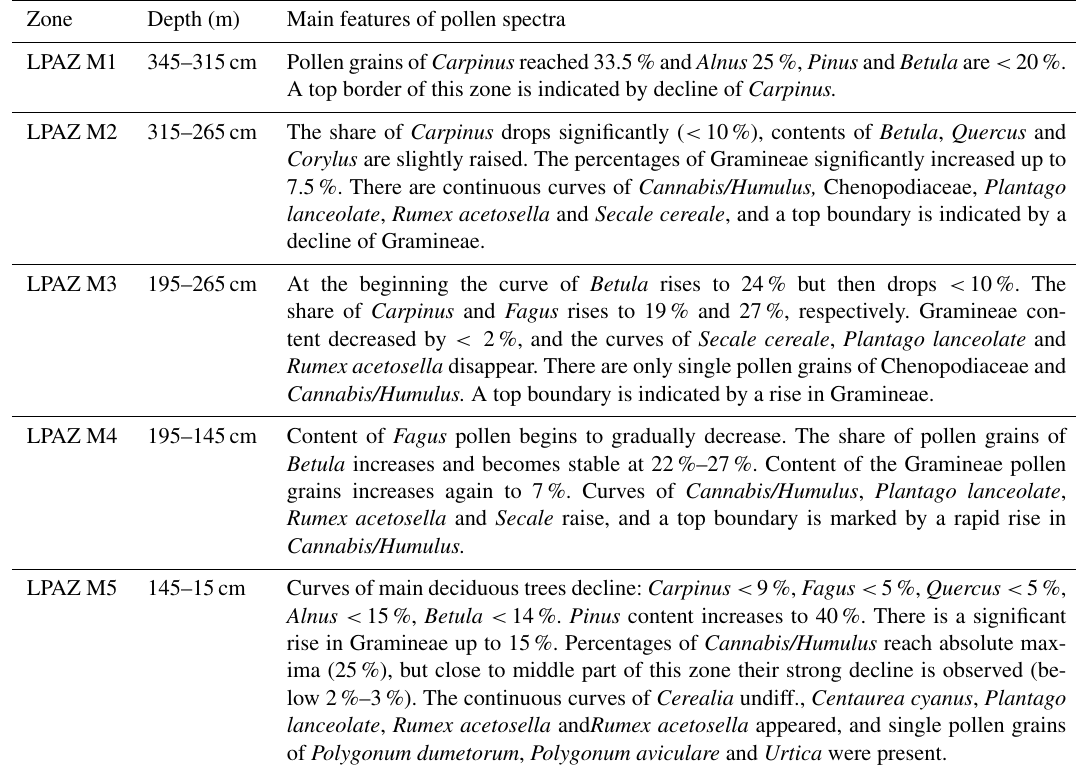
Table 2. Local pollen assemblage zones of the Lake Młynek. Zone Main features of pollen